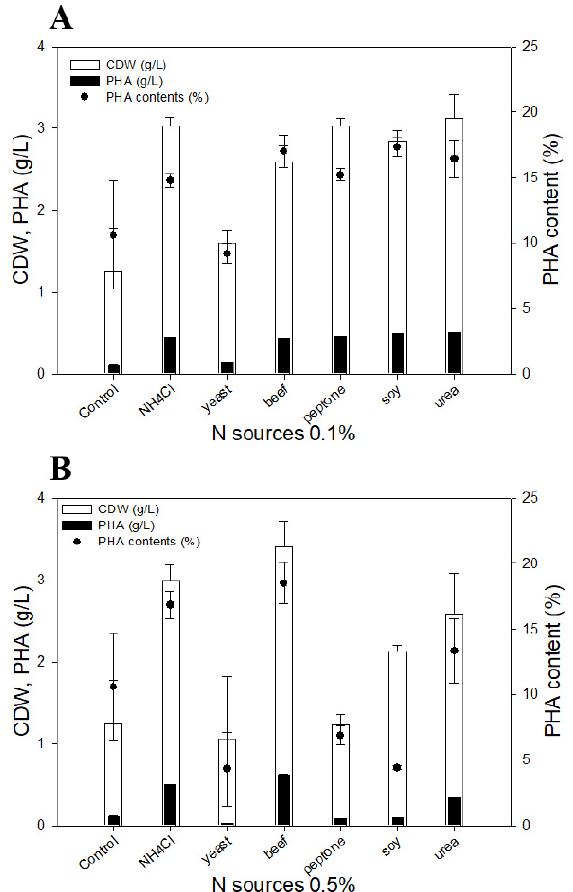
Figure 4. Nitrogen sources comparison for PHA production. Six different nitrogen sources were evaluated at 0.1% ( A ) and 0.5% ( B ) concentration; 2% coffee oil was used in the culture as a constant.